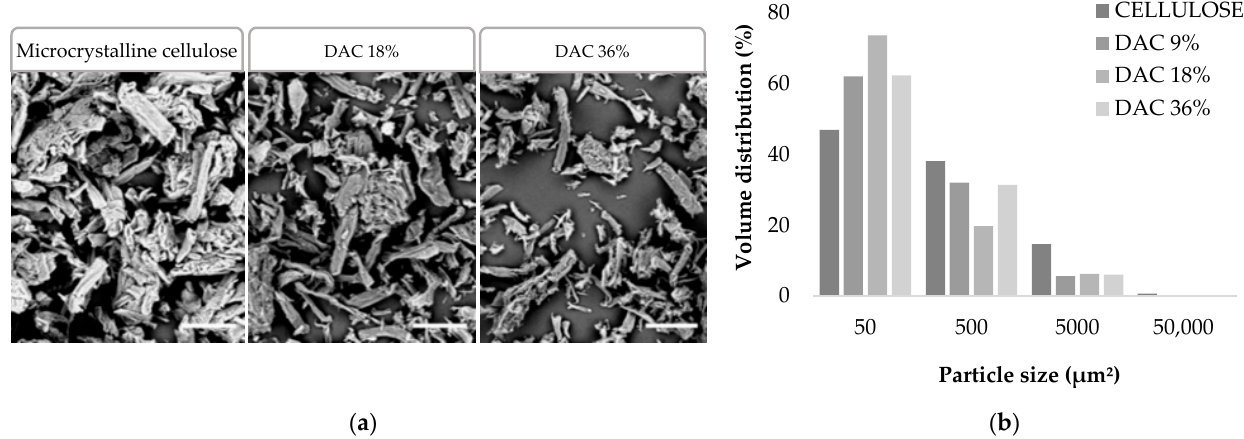
Figure 2. ( a ) MEB visualisation (Scale bar = 100 µm) and ( b ) Granulometric distribution of cellulosic powders.